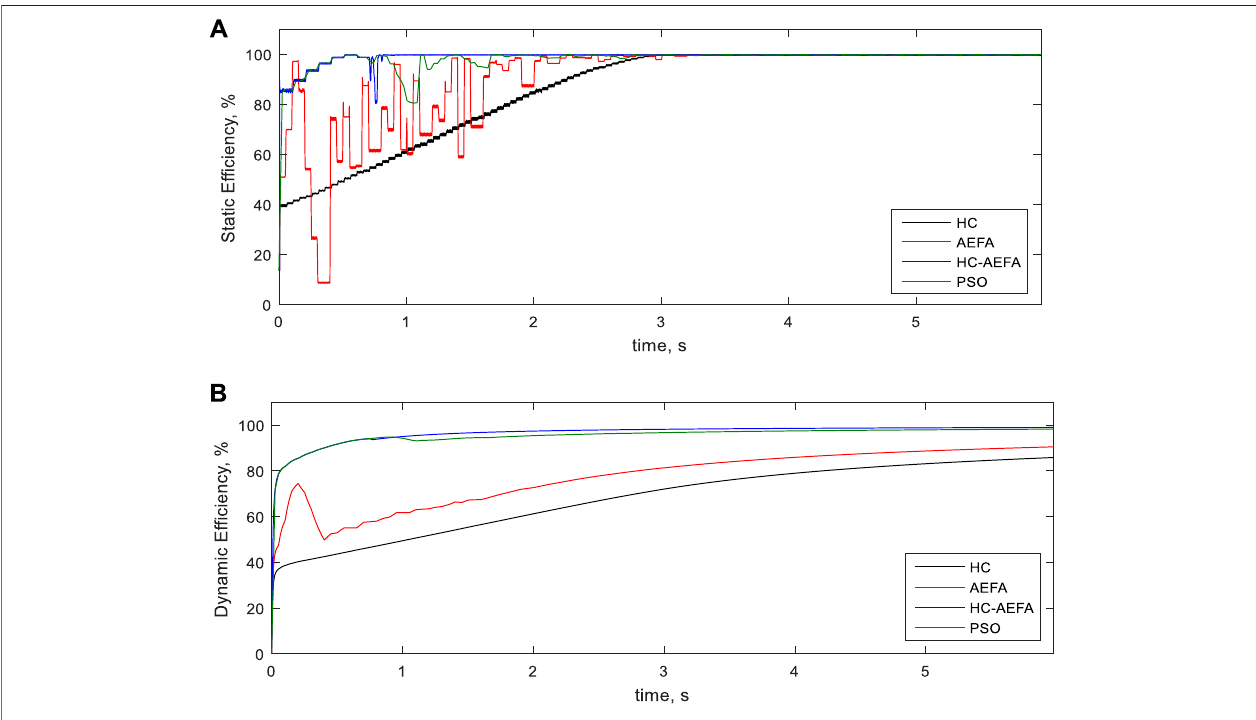
FIGURE 5 | Ef fi ciency curves at the fi rst pattern obtained using the HC-AEFA, HC, AEFA, and PSO methods; (A) Static-ef fi ciency, and (B) Dynamic- ef fi ciency.